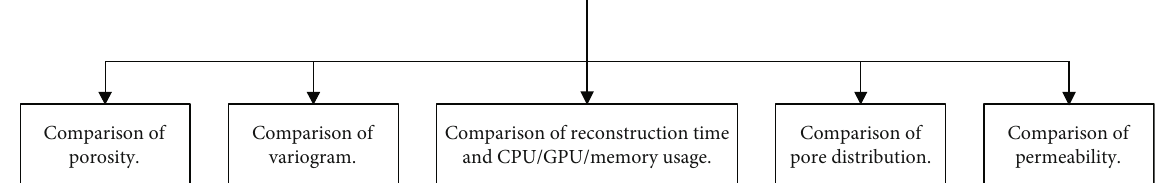
Figure 1: The sketch of the research technical route of this paper.